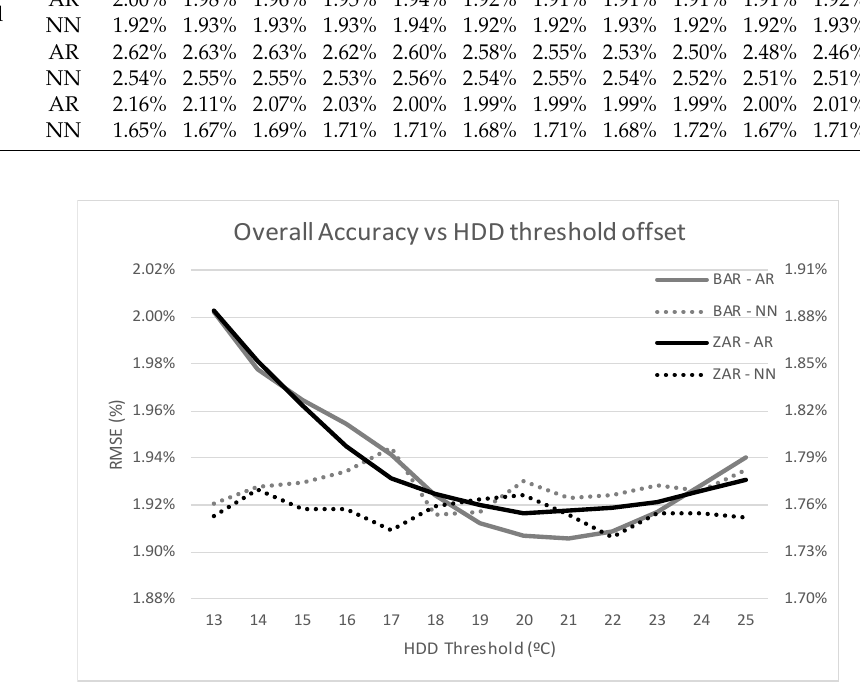
Figure 10. Overall forecasting error (RMSE) with different HDD threshold adjustment in Barcelona and Zaragoza.